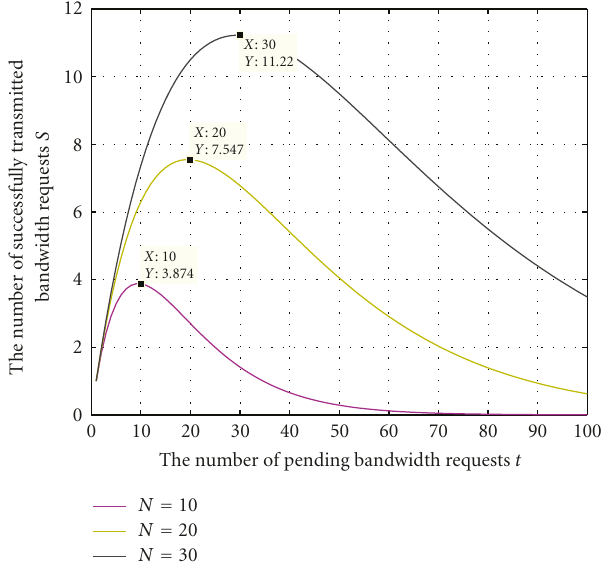
Figure 6: The number of successful transmission with N = 10, 20, 30.